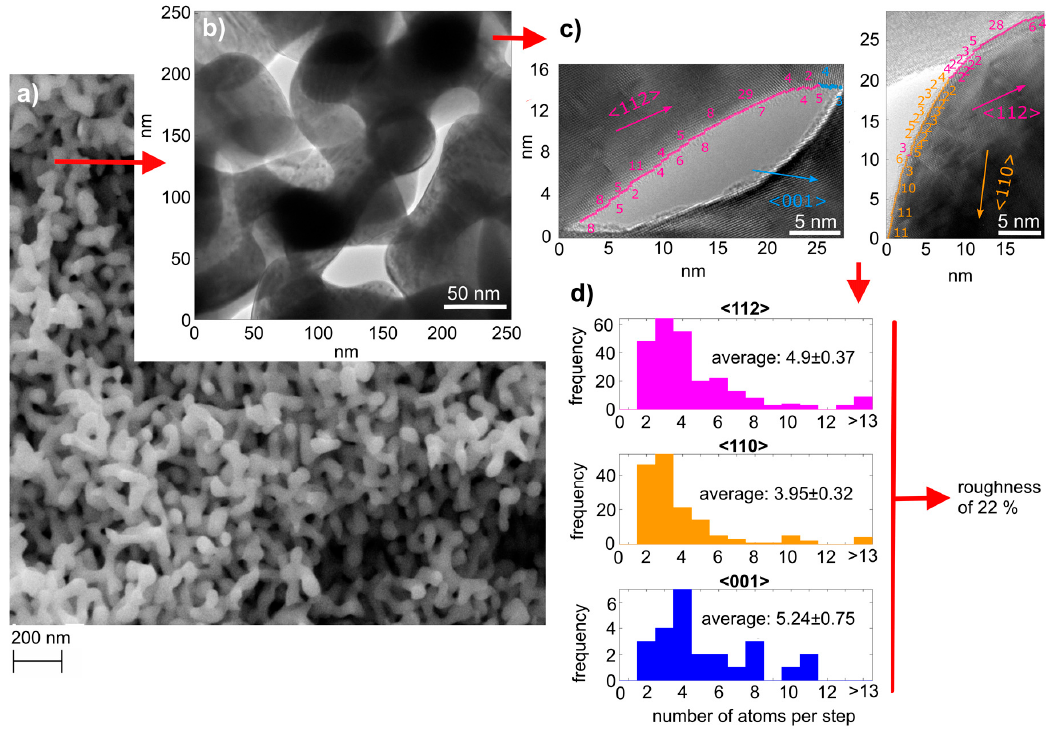
Figure 1. ( a ) Representative SEM and ( b ) TEM images of npAu after catalysis containing less than 1 at% Ag and prepared via FC from a Au 25 Ag 75 starting alloy. Catalytic methanol oxidation was performed at 60 °C and 3 bar oxygen for 24 hours with 12 mM KOH as a base. ( c ) The density of